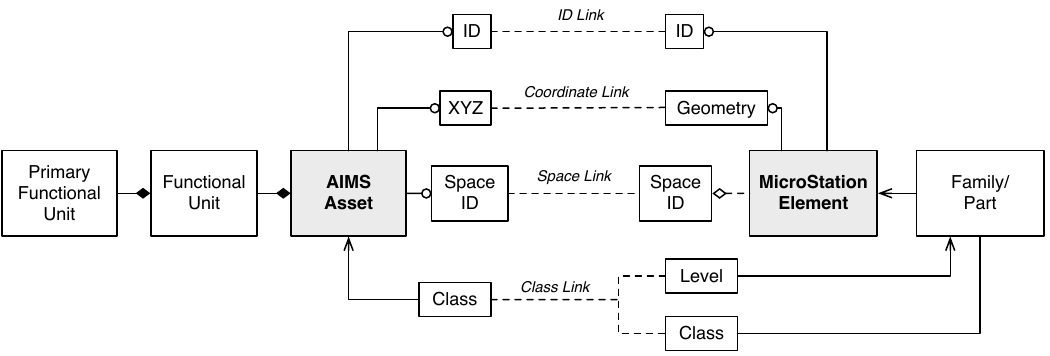
Figure 2. Direct, Spatial and Semantic methods of linking AIMS and CAD